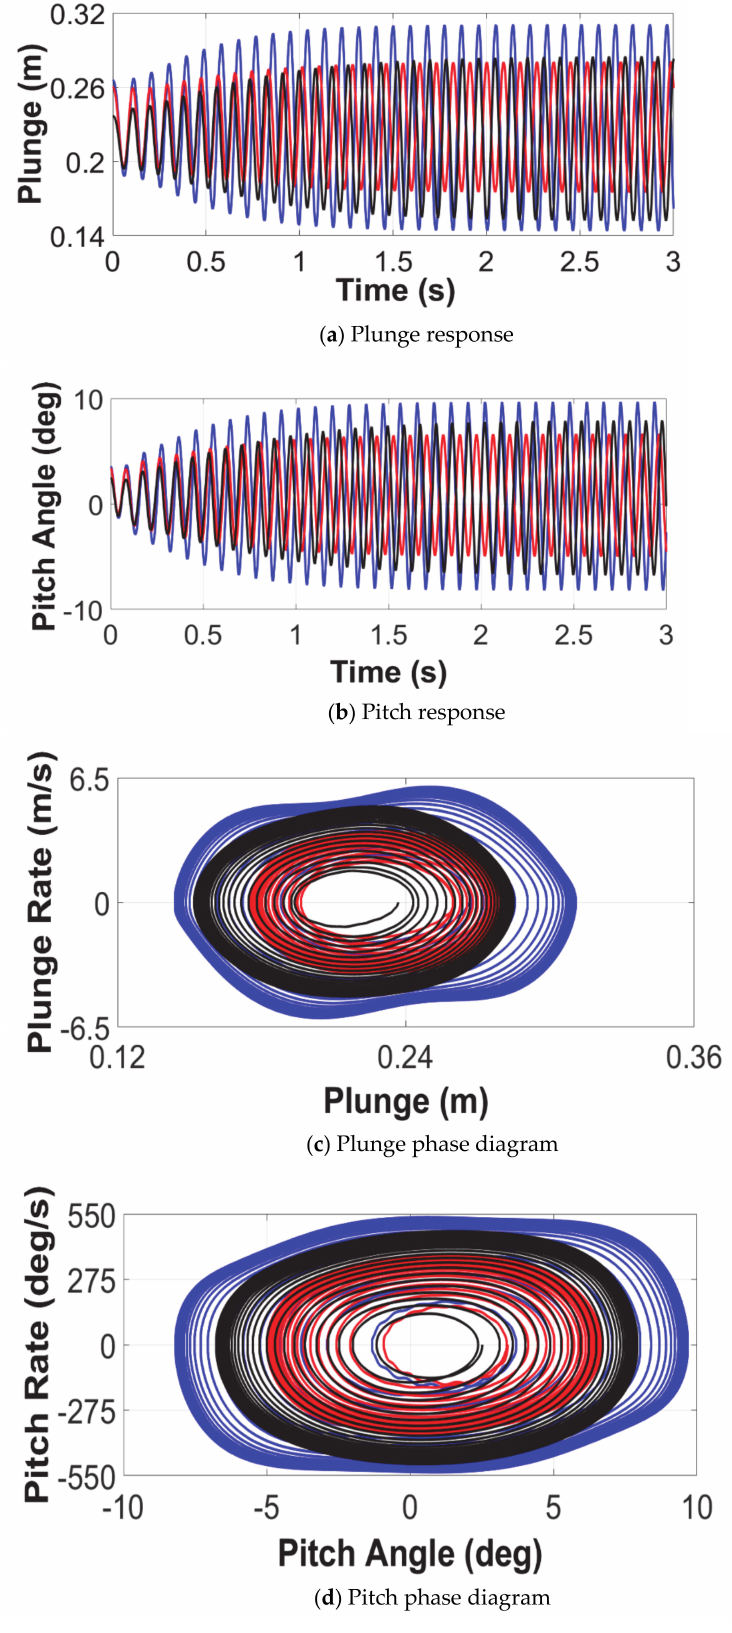
Figure 16. Time history of the wing equipped with nonlinear